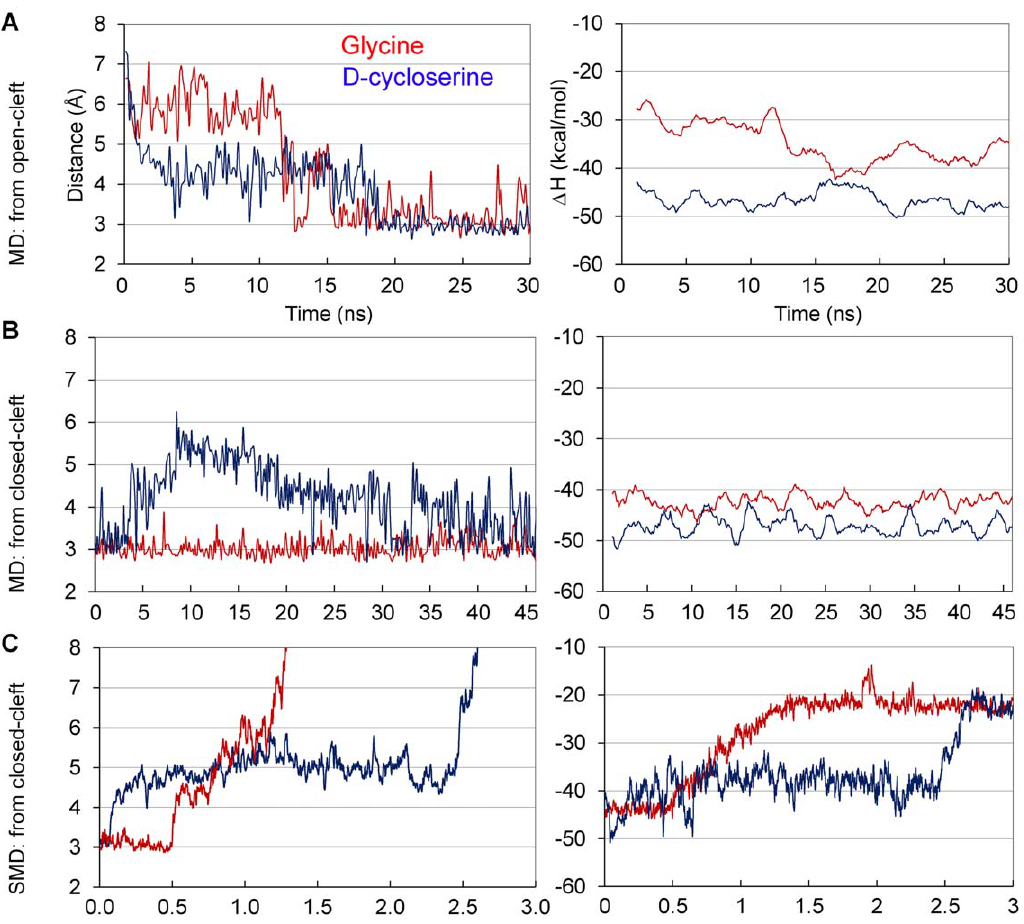
Figure 3. Relationship of GluN1-LBD closure and D H in ligand binding. Free MD simulations starting from (A) open and (B) closed LBD, and (C) SMD simulations (9 pN) from a closed LBD. The distances (left panel) are IHB distances (Gly485 N -Gln686 O ). Corresponding binding enthalpies ( D H) from the simulations are shown in the right panel. Results from all the SMD simulations performed are shown in Figure S2.